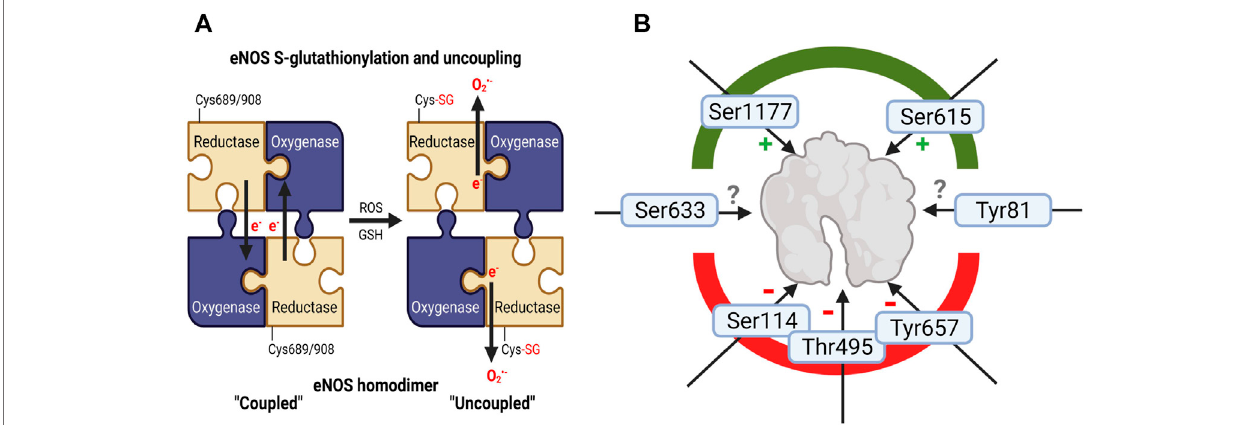
FIGURE3 | Adverseregulation ofeNOS function bynoise. (A) Schematic explanation ofincreased eNOS S-glutathionylation in mouse tissues (a surrogate marker foruncouplingoftheprotein)uponnoiseexposure(Munzeletal.,2017;Kroller-Schonetal.,2018;Stevenetal.,2020).Inthe “ coupled ” eNOShomodimer,electronsare usually transferred from the NADPH and fl avins to the hem iron. Cysteine residues 689 and/or 908 undergo S-glutathionylation with structural changes (Chen et al., 2010), followed by misdirection of the electrons to molecular oxygen and superoxide formation, termed “ uncoupled ” state of eNOS. (B) eNOS activity is regulated by various kinase-dependent modi fi cations such as activating phosphorylation at serine 1177 or Ser615 and inactivating ones at serine 114, threonine 495 (or 497 dependingonthespecies)andtyrosine657(FlemingandBusse,2003;Mountetal.,2007).AlthoughpThr495-andpTyr657-eNOSwasnotreportedfornoiseexposure, these inactivating phosphorylations may be expected since they are mediated by oxidatively activated kinases (PKC and PYK-2). Whereas higher eNOS protein expression and Ser1177 phosphorylation was observed in noise (4d)-exposed mice indicating counterregulatory upregulation and activating modi fi cation to rescue uncoupling of eNOS enzyme (Munzel et al., 2017; Kroller-Schon et al., 2018), suppression of pSer1177-eNOS was observed in noise-exposed hypertensive mice exposed to 7 days of noise (Steven et al., 2020). Other eNOS phosphorylation sites are not completely explored with respect to their functional effects (Ser633 and Tyr81). Image was created using